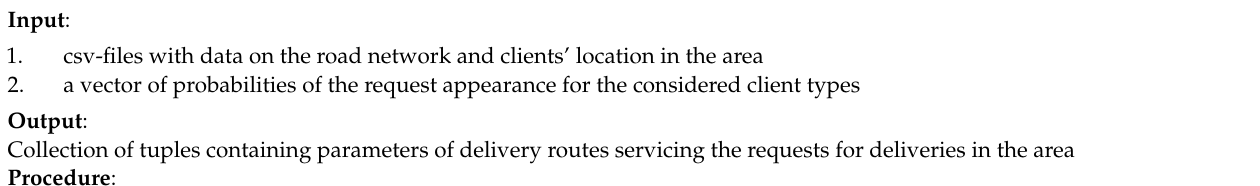
Algorithm 1. Simulation of a delivery processes.